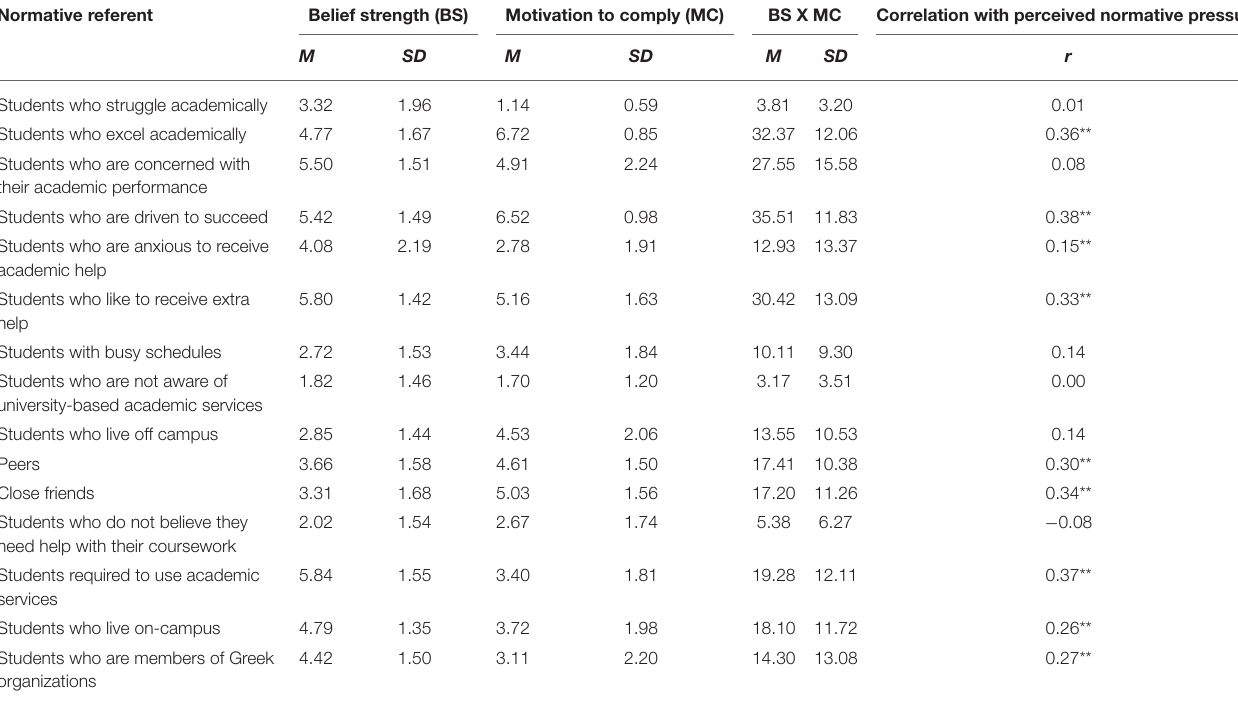
TABLE 5 | Descriptive normative beliefs and correlations with normative